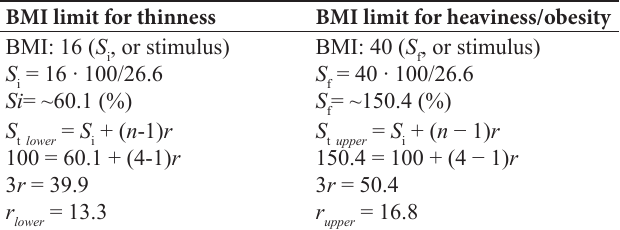
Table 2. Example of the calculation of two sub-scales of a geometric progression of a limited scale of image sizes for a participant (BMI =